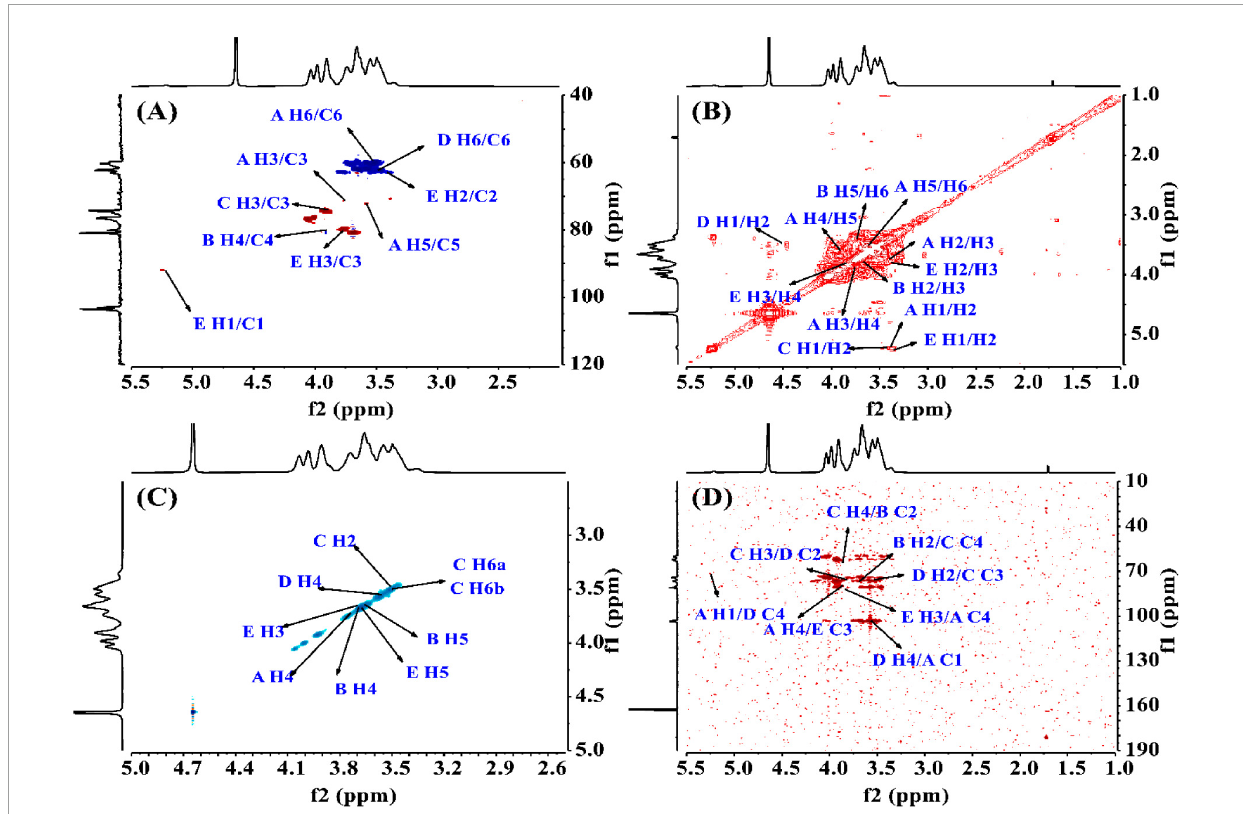
FIGURE4 The structural elucidation of PKP2-1 by NMR analysis. (A) HSQC NMR spectrum; (B) 1 H- 1 H COSY NMR spectrum; (C) NOESY spectrum; (D) HMBC spectrum.